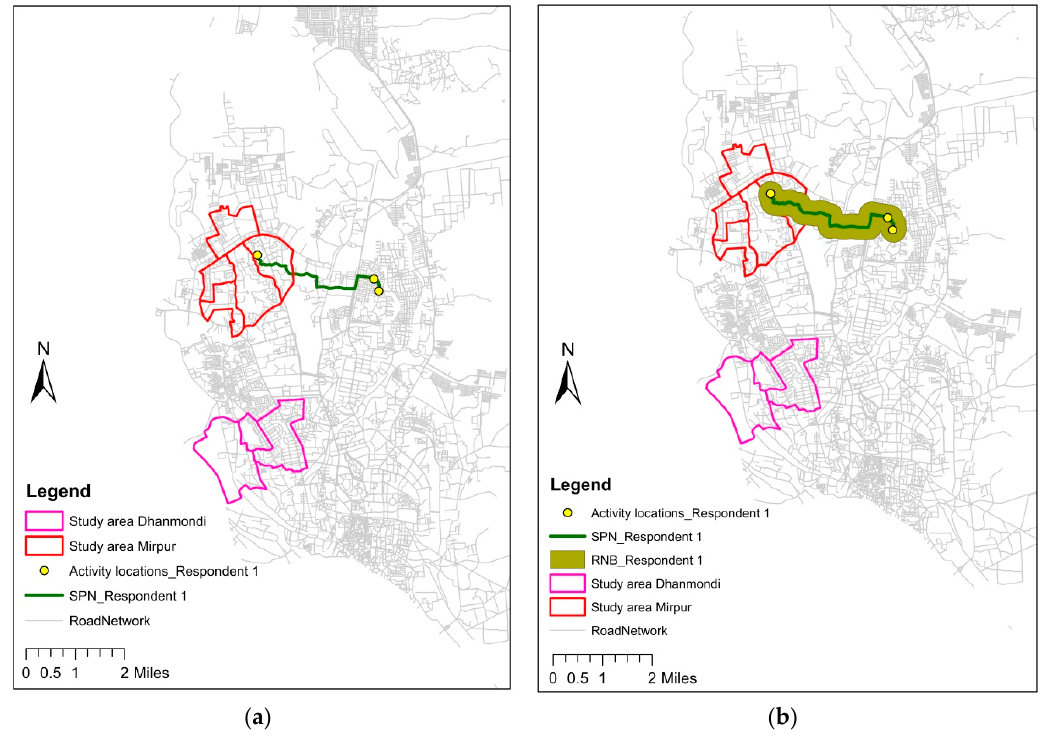
Figure 6. Visualizing activity space: example of ( a ) shortest-path network (SPN) with ( b ) 400-m road network buffer (RNB) for one respondent (home location: Mirpur).